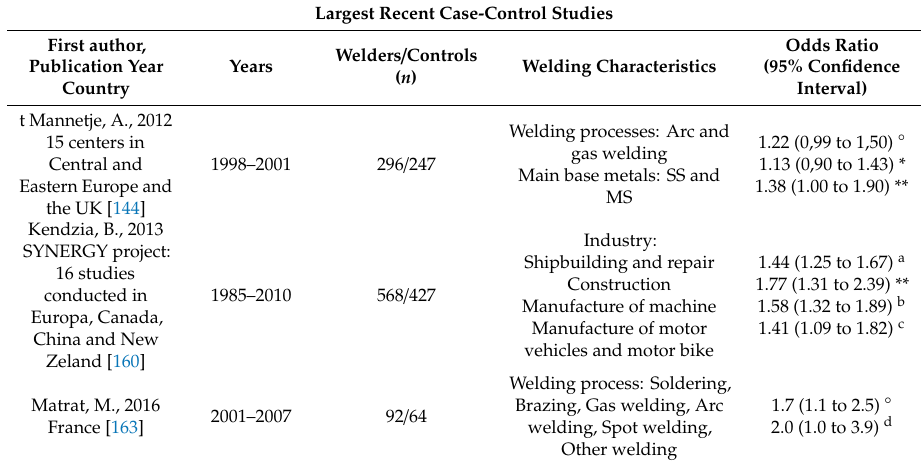
Table 5. Risk for lung cancer in welders: Largest recent case-control